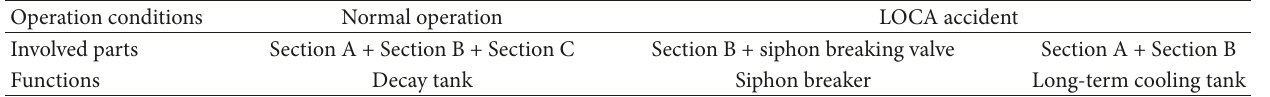
Table 1: Operating conditions of integrated passive safety system.